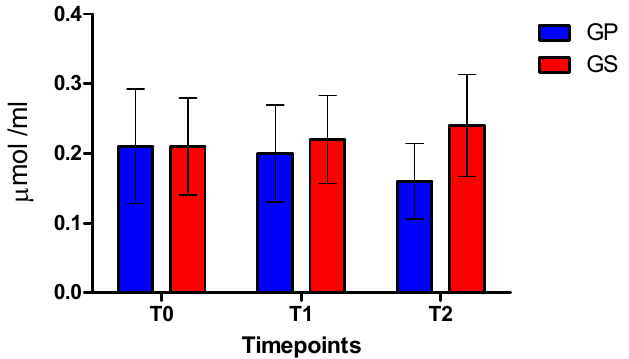
FIGURE 4 - Blood pyruvate levels (micromoles per mililiter) in children anesthetized with Propofol (GP) or Sevoflurane (GS). Bars represent mean±SD of GP (blue bars) and GS (red bars) groups at T0, after radial artery cannulation, T1, 30 minutes after cardiopulmonary bypass launch and T2, at the end of the surgical procedure. Values in T0, T1 and T2 timepoints are not significantly different in each group by Friedman´s test. GS is not different from GP group by Wilcoxon test.